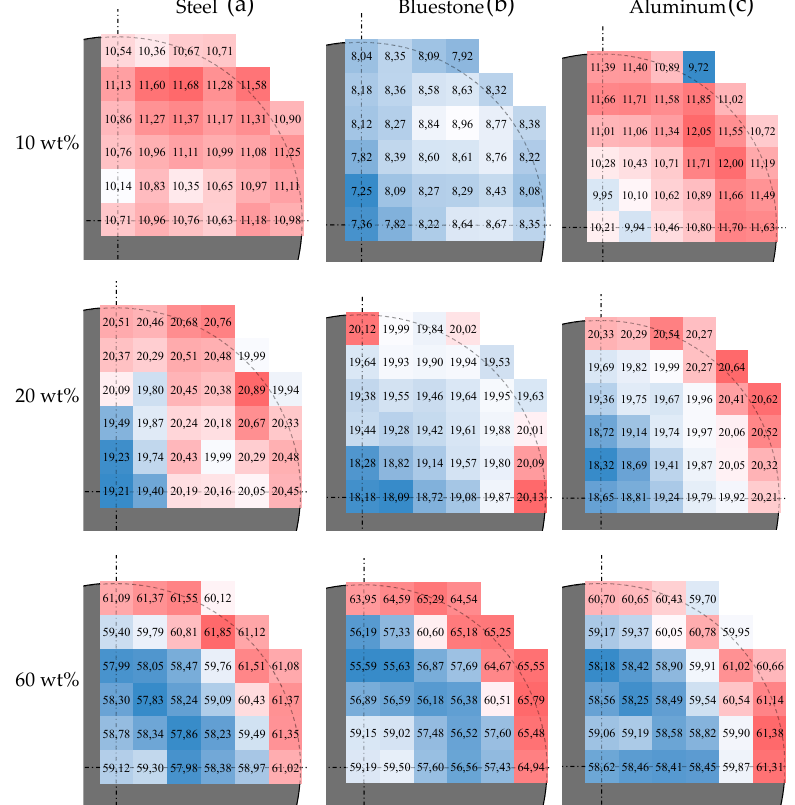
Figure A7. Characteristic fiber content distribution pattern for disc segments of 10 wt.%, 20 wt.%, and 60 wt.% initial nominal fiber content: steel tool ( a ), Bluestone tool ( b ), and aluminum tool ( c ). The color scheme describes values below (blue) up to values near (white) and values above (red) the initial nominal fiber content (in accordance with Figure